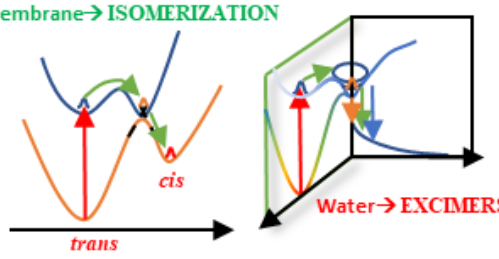
Fig. 1. Sketch of the photodynamics in DMSO, SDS and water as suggested by the TA